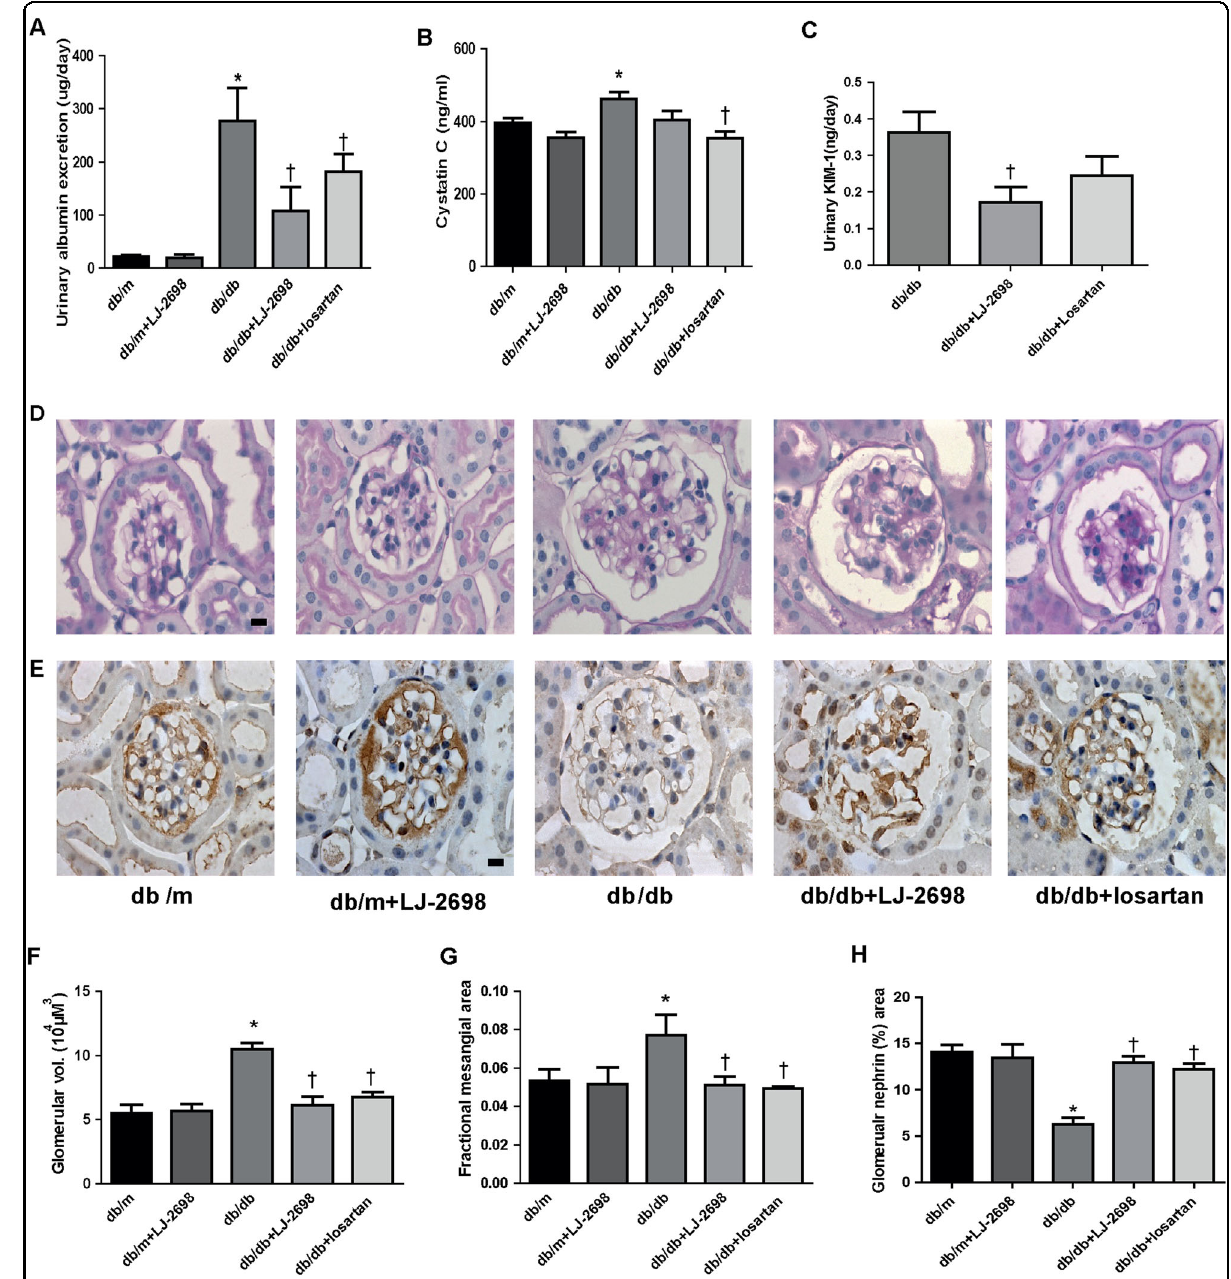
Fig. 4 LJ-2698 prevented kidney injury in db/db mice. LJ-2698 (10 mg/kg) was administered in db/db mice and age-matched control db/m mice for 12 weeks. Losartan (1.5 mg/kg) was administered in diabetic mice to compare with the effect of LJ-2698. After 12 weeks of treatment, urine and plasma were collected for analysis of ( a ) urinary albumin, ( b ) plasma cystatin C, and ( c ) urinary KIM-1. Paraf fi n-embedded kidney sections were stained with ( d ) PAS staining and ( e ) nephrin antibody. The scale bar indicates 10 μ m, original magni fi cation was ×630. Quantitative analysis of ( f ) glomerular volume, ( g ) FMA, and ( h ) glomerular nephrin area are depicted. Data are presented as the mean ± SE of 7 – 10 mice/group. * p < 0.05 vs. db/m and † p < 0.05 vs. db/db